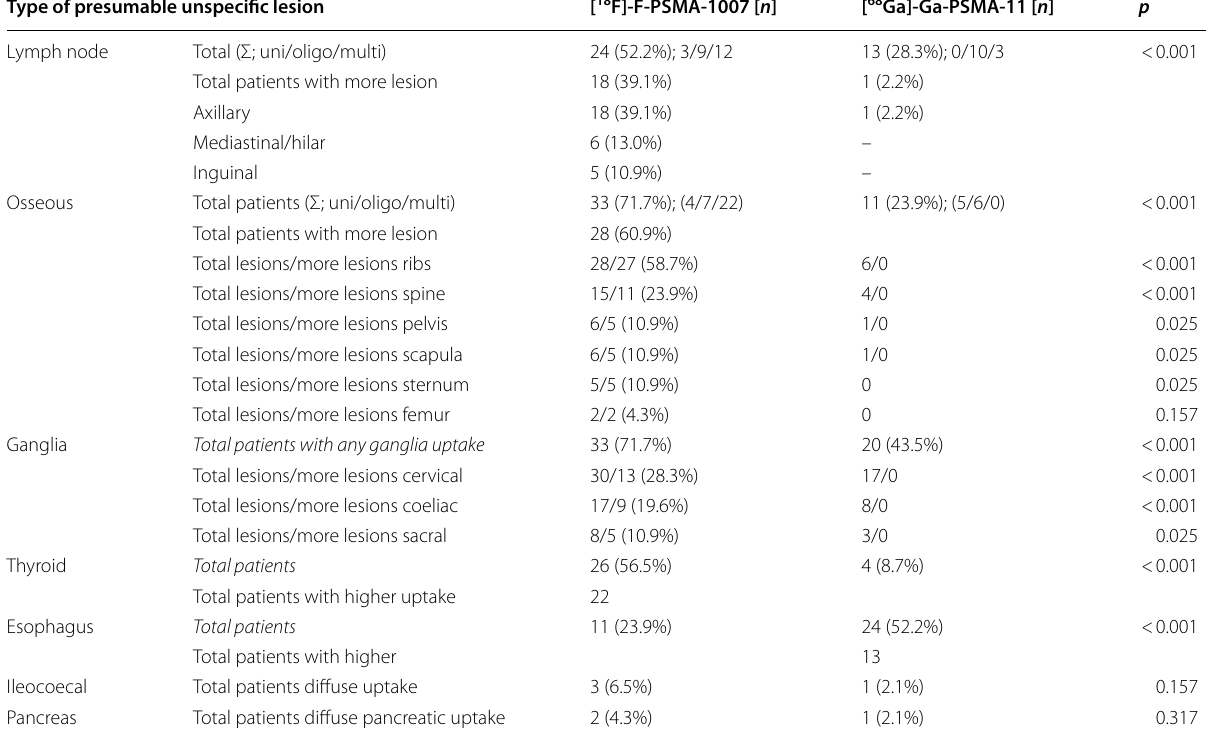
Table 8 Prevalence of discordant presumable unspecific lesions Type of presumable unspecific